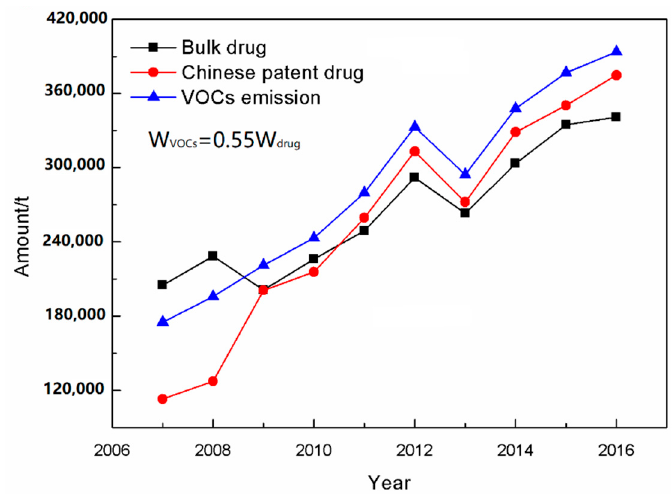
Figure 1. The production of bulk drugs and Chinese patent drugs and VOCs emissions from 2007 to 2016.